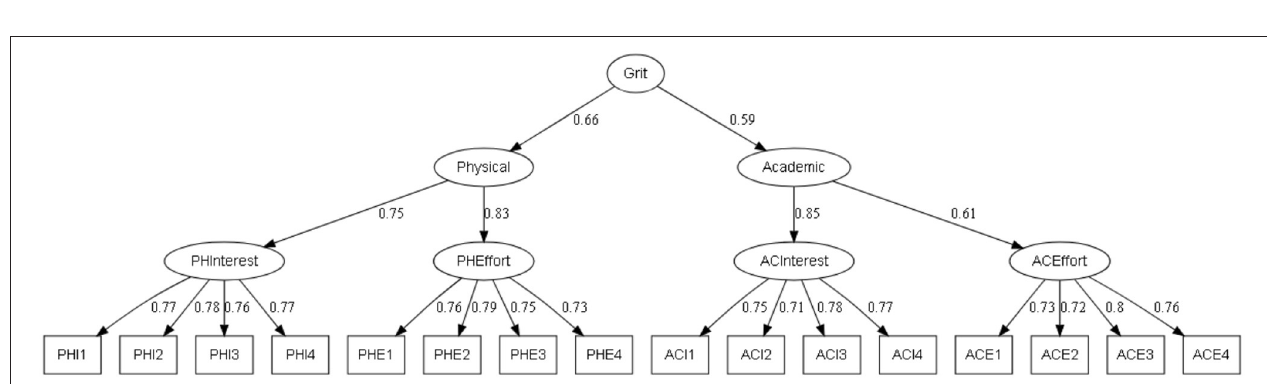
FIGURE 3 | Third-order factor analysis of the PE-Grit (M3). All parameters are standardized and significant at the 0.01 level.